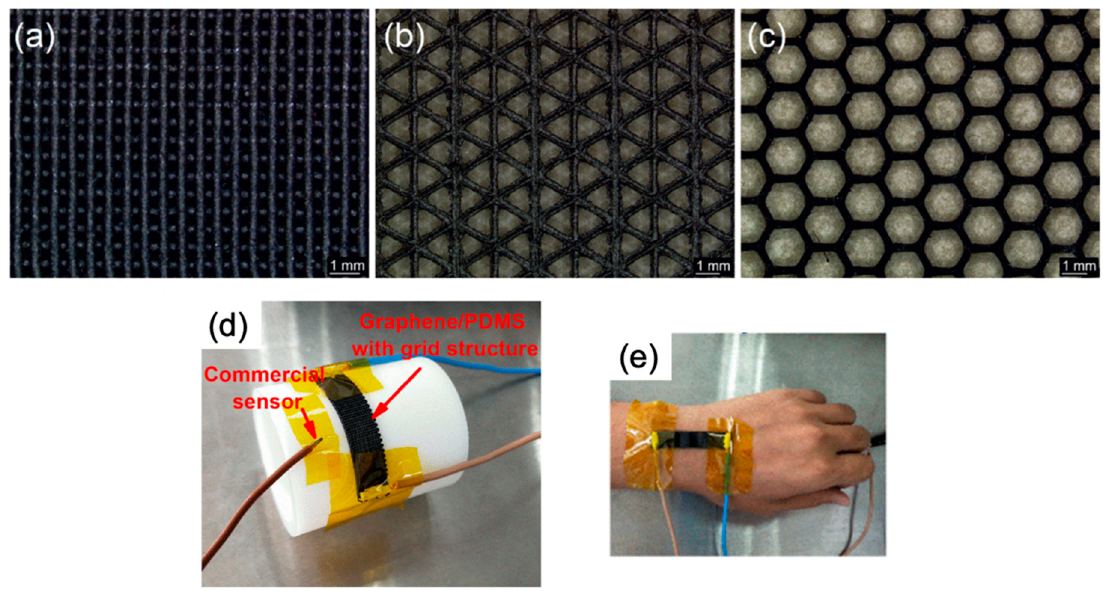
Figure 4. Optical images of the 3D-printed graphene/PDMS composites: ( a ) grid structure; ( b ) triangular porous structure; and ( c ) porous hexagonal structure. Monitoring the cooling process on a curved surface, ( d ) experimental setup, ( e ) simultaneous monitoring of wrist skin temperature. 2019, American Chemical Society©.